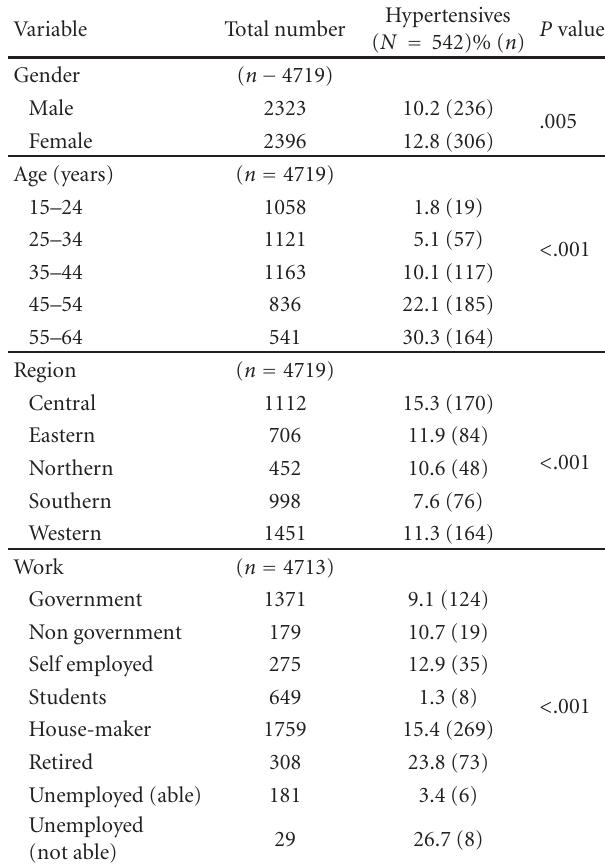
Table 1: Prevalence of hypertension according to the sociodemo- graphic